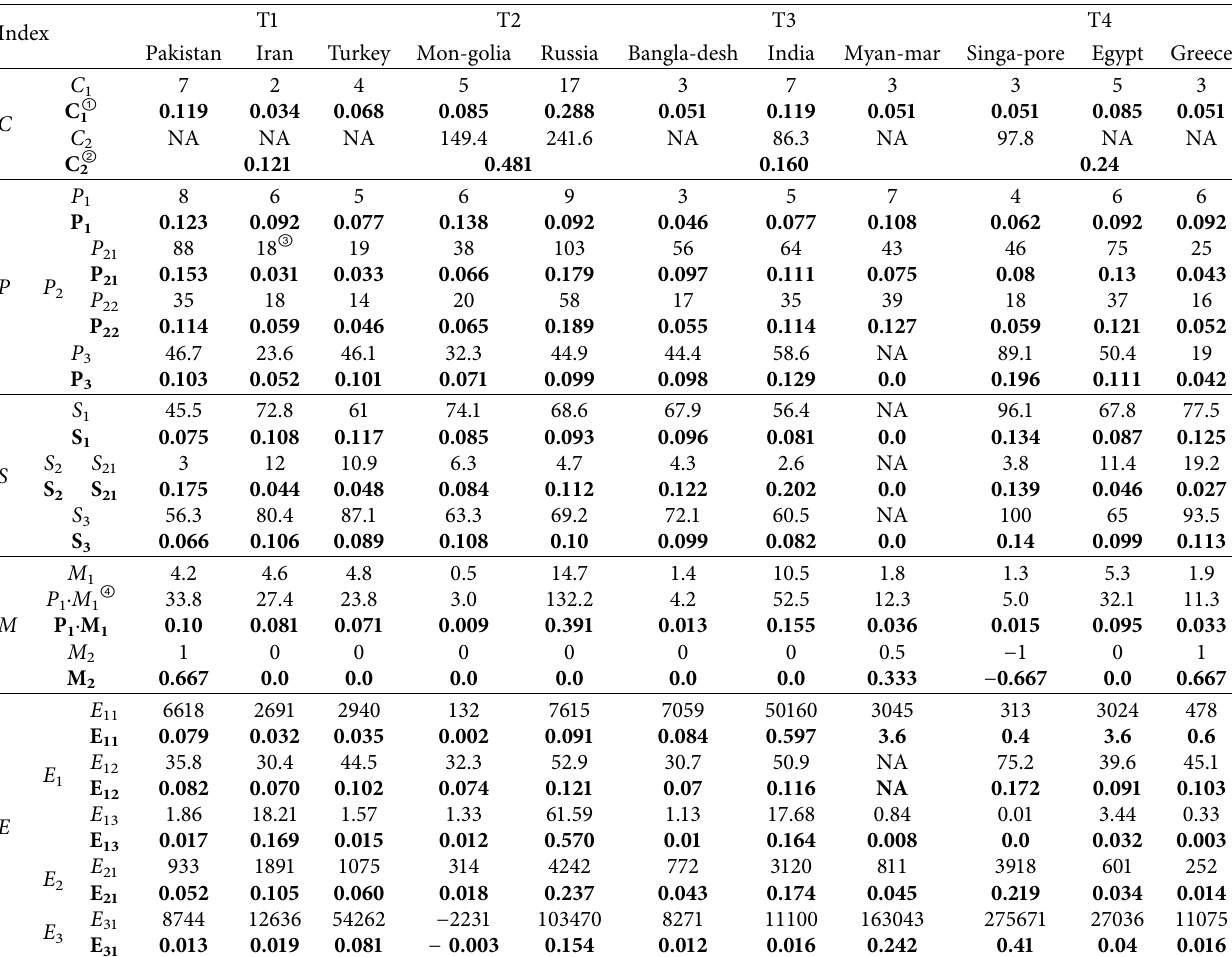
Table 5: Raw and normalized data of SVITC for the four corridors and 11